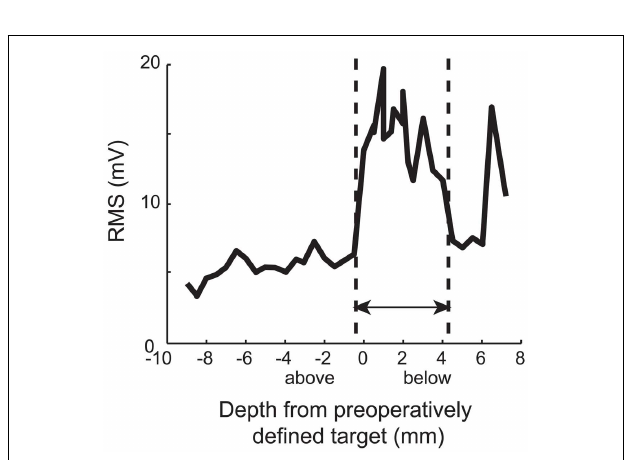
FIGURE 2 | Electrophysiological traces taken along a trajectory to and though the STN from a mapping pass of a single tract in early PD (one of four tracts) .Ten-second long traces were taken but for ease of visualization of detail, the first 5s are shown. Y -axes scaled identically to bottom panel.These traces are typical of what is encountered when